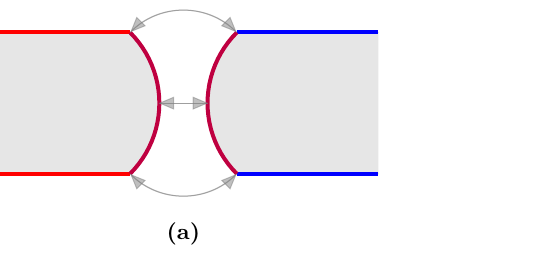
Figure 10. Cut-away views of interface brane solutions in AdS 3 (a) In global coordinates, the interface is at y = 0 . The CFT interface extends into the bulk as an interface brane (purple). The two faces of the interface brane are described in (5.8) and (5.9). (b) In Poincaré coordinates, the CFT interface is a circle. The two faces of the interface brane form portions of spheres, see equation